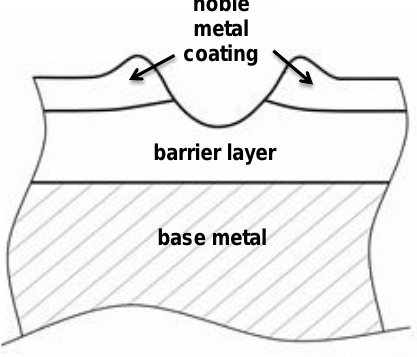
Figure 3. Wear pattern I—total wear out of the final coating. Cross-section of plating system of electrical contacts after the wear and fretting corrosion test.